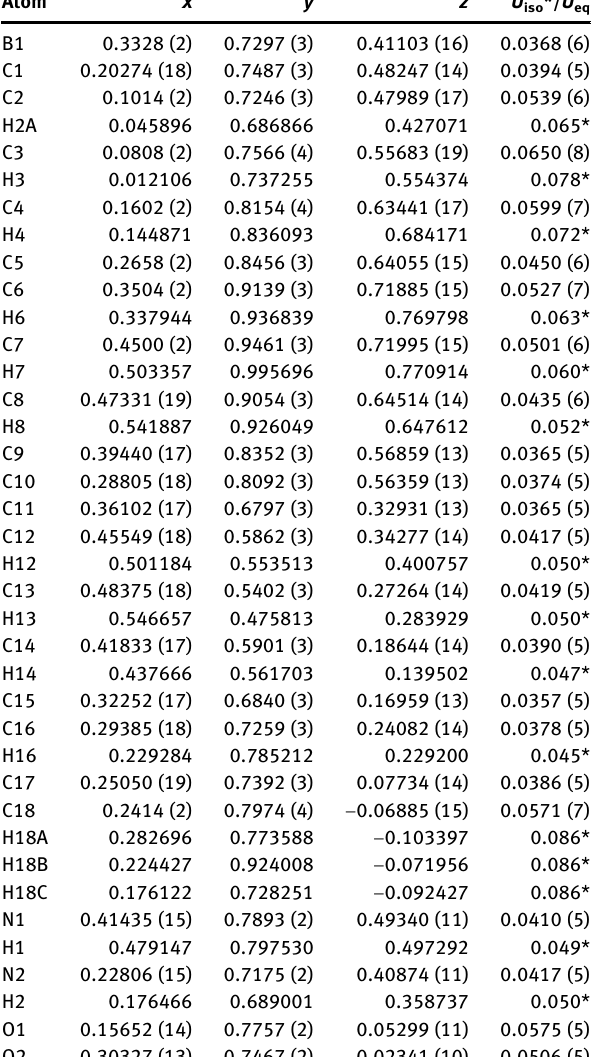
Table  : Fractional atomic coordinates and isotropic or equivalent isotropic displacement parameters (Å 